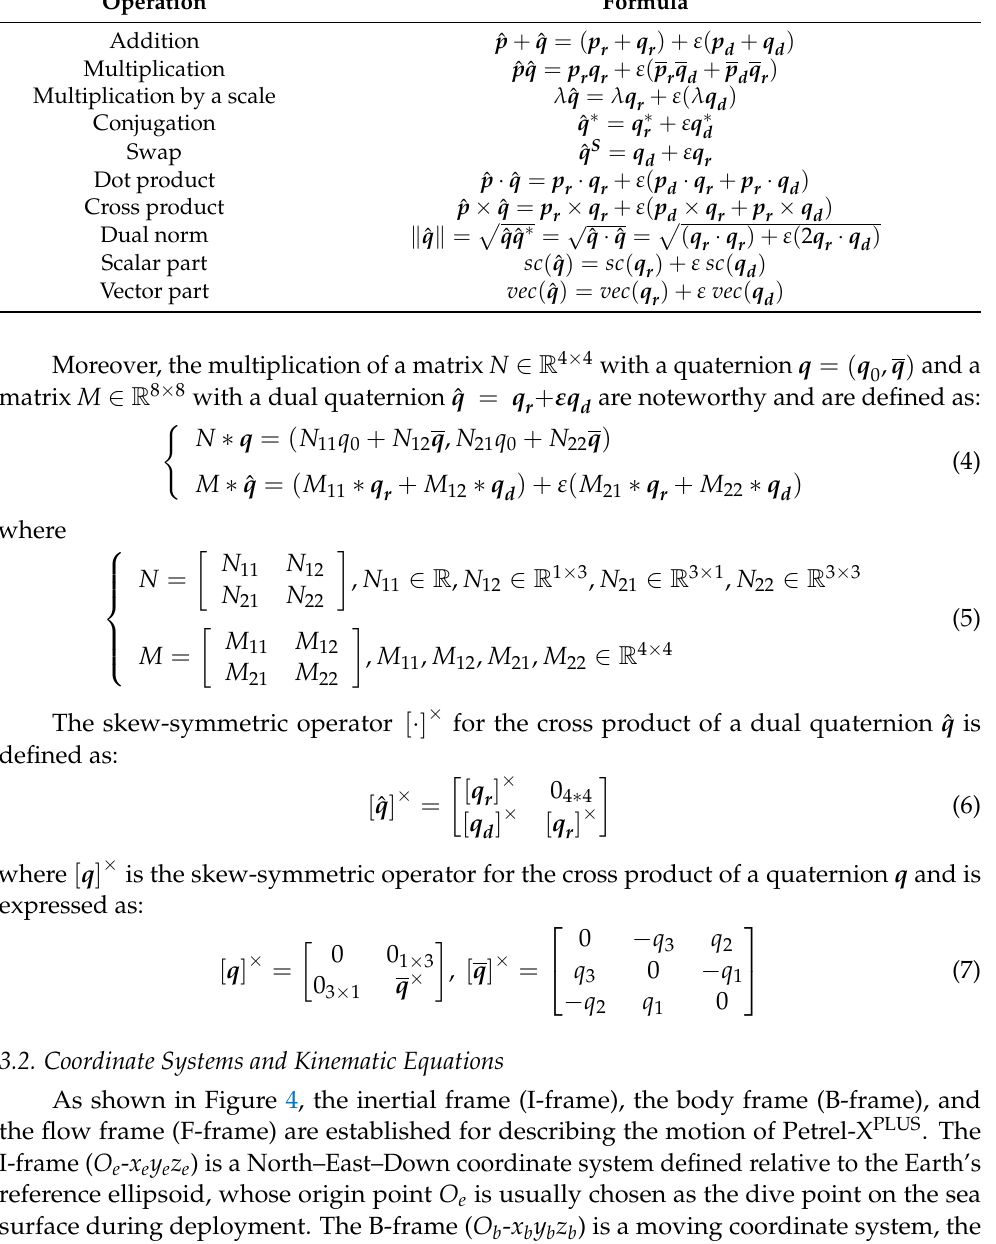
Table 1. The basic operations of dual quaternions. Operation Formula